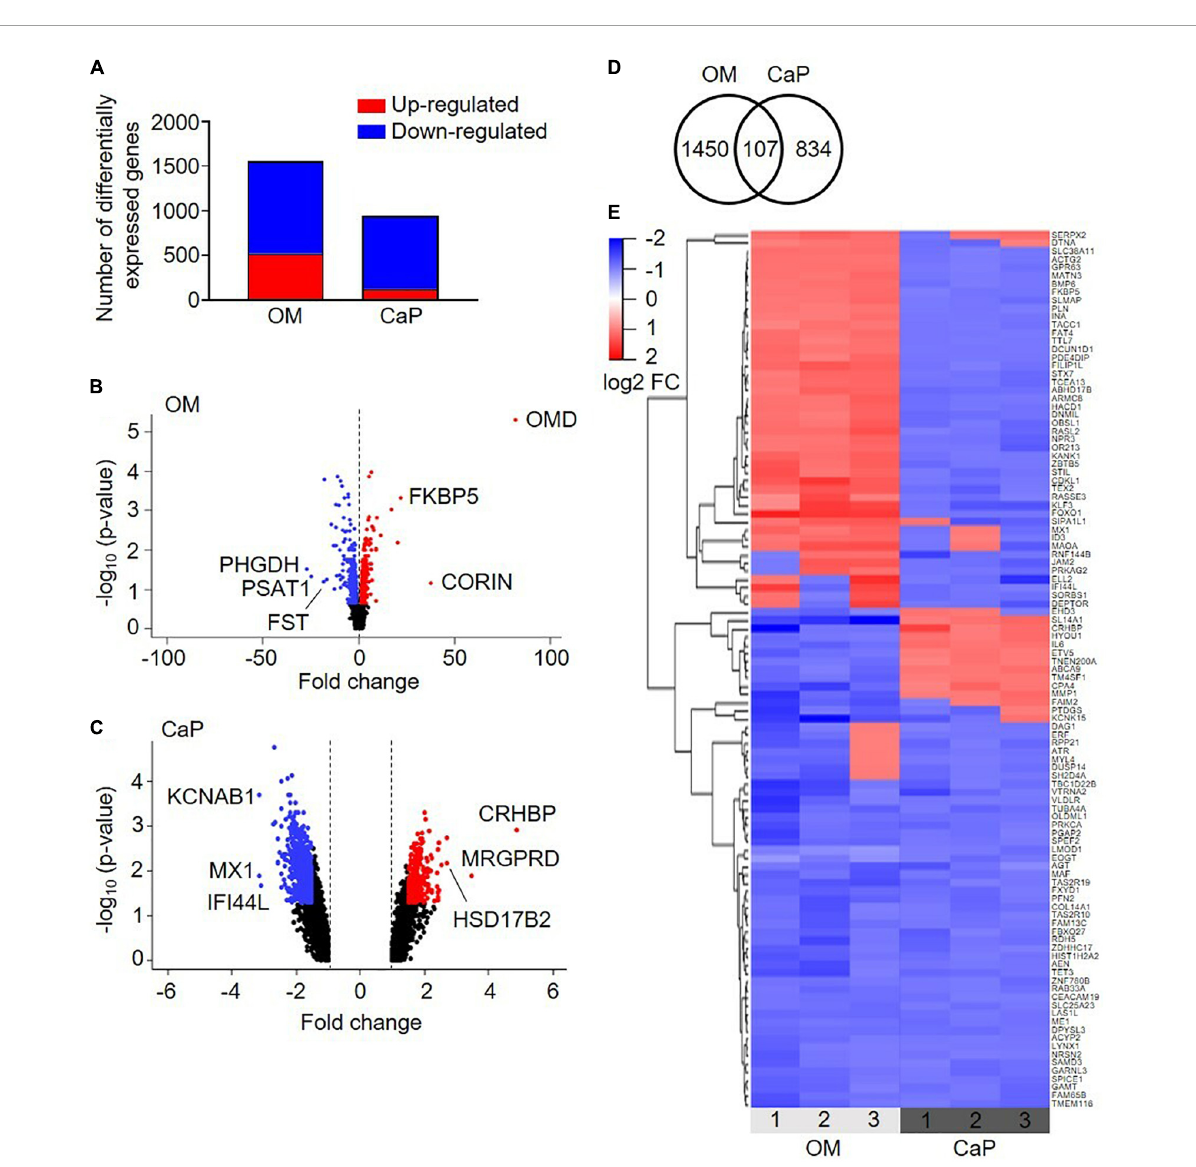
FIGURE2 Transcriptional profiling of osteogenic (OM) and calcium phosphate (CaP)-calcified primary coronary artery smooth muscle cells (pSMCs). (A) Number of up-regulated (red) and down-regulated (blue) genes from OM and CaP-calcified pSMCs compared to control (CM). Cut-off FC 1.5. (B,C) Volcano plots of the differentially expressed genes in OM and CaP-calcified pSMCs, respectively, compared to CM. Plotted on the x -axis is the fold change between calcified and CM pSMCs. Plotted on the y -axis is the –log 10 ( p -value). Significant differentially expressed genes are divided into up-regulated (red dots) and down-regulated (blue dots) genes, while non-significant genes are shown in black. The top three up-and downregulated genes are named. (D) The Venn diagram shows overlapping differentially expressed genes between OM and CaP-calcified pSMCs. (E) Heatmap presenting the expression profiles of the 107 common genes. Genes with a fold change ≥ ± 1.5 and a p -value < 0.05 are considered differentially expressed. n = 3 independent primary SMC